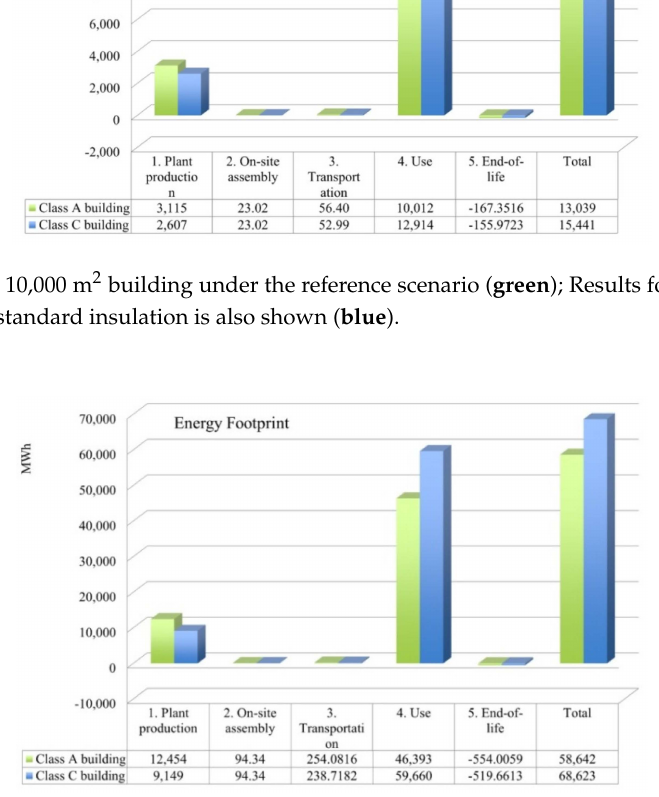
Figure 10. EF of a 10,000 m 2 building under the reference scenario ( green ); Results for an energy class C building with standard insulation is also shown ( blue